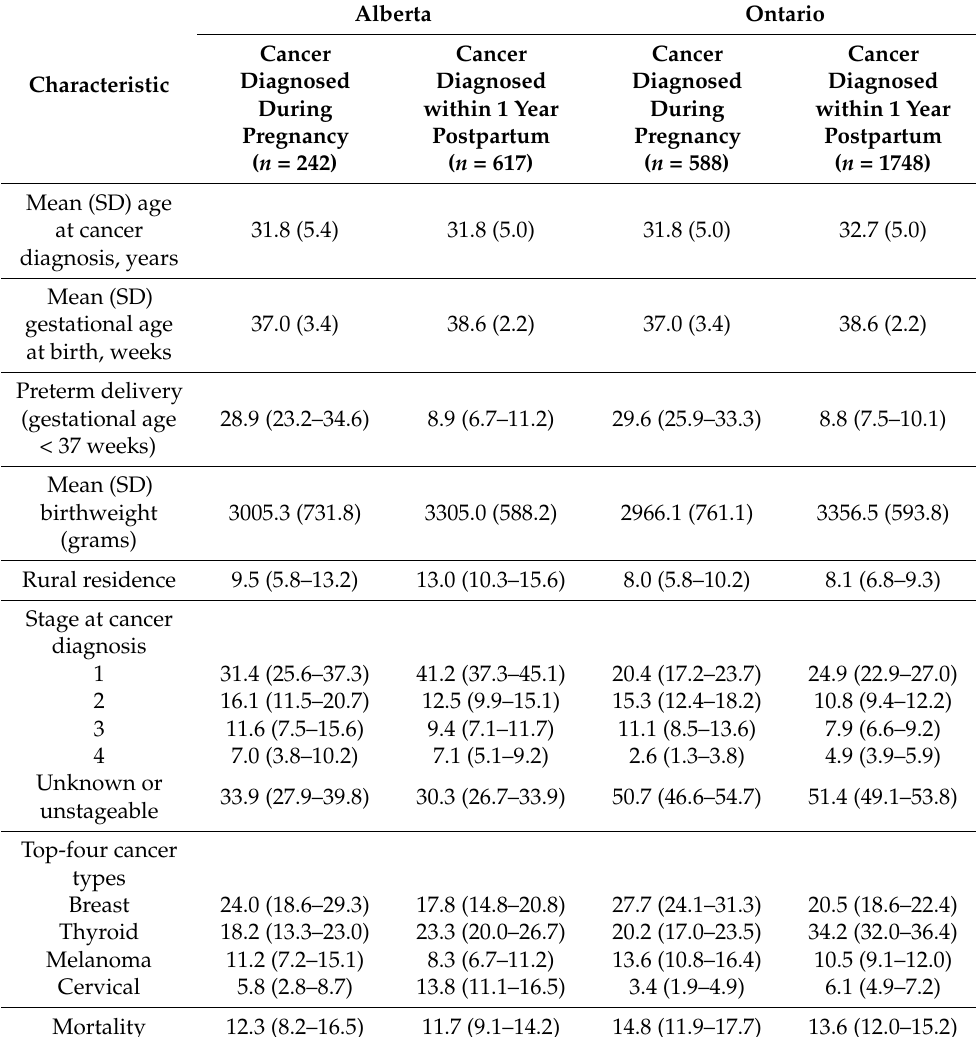
Table 1. Characteristics of women with pregnancy-associated cancer in Alberta and Ontario,